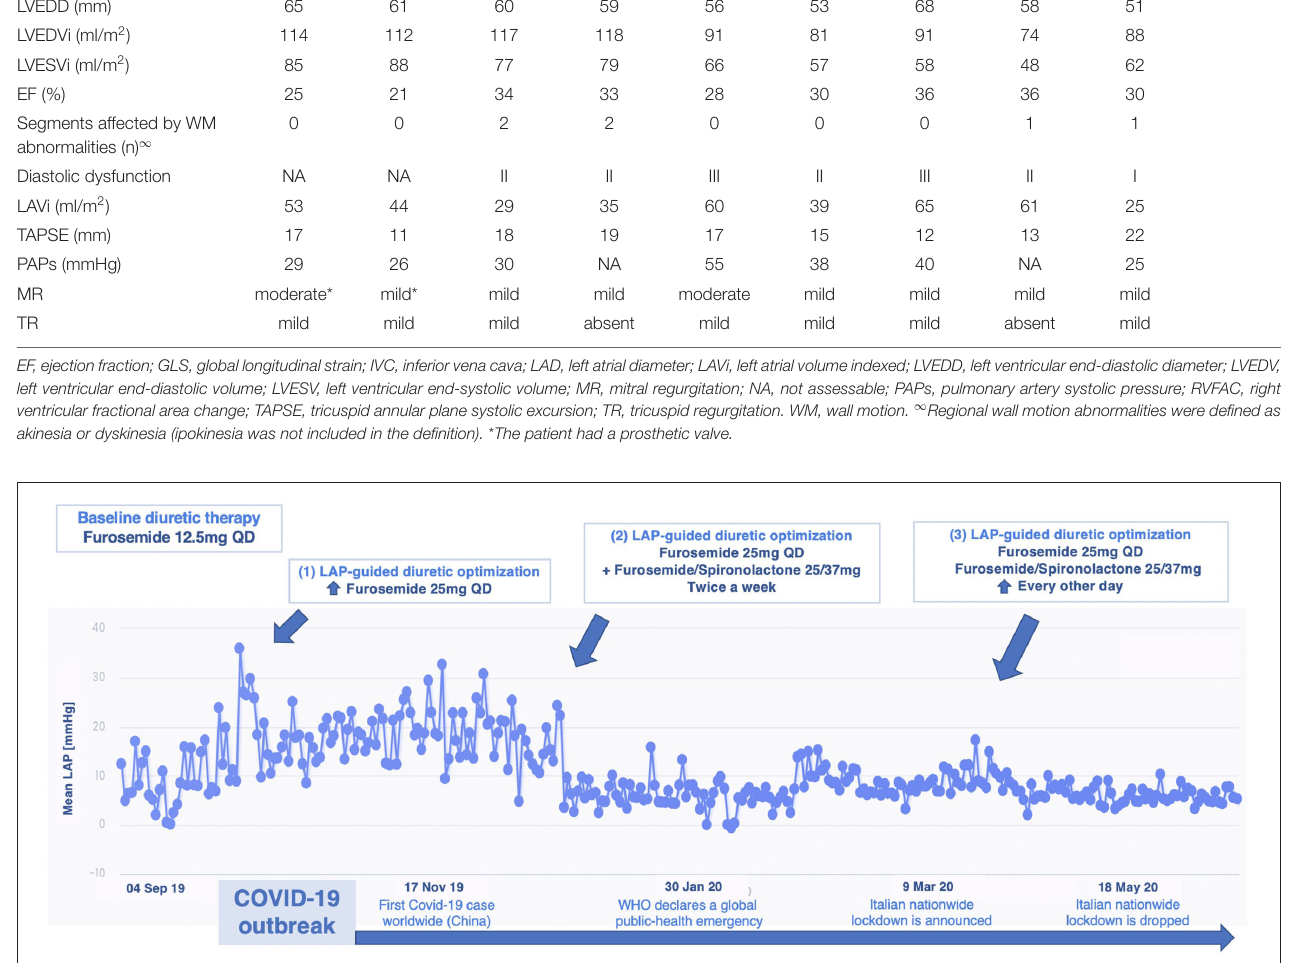
and in NT-proBNP values (from 3,131 pg/ml at baseline to 2,868 pg/ml at most recent